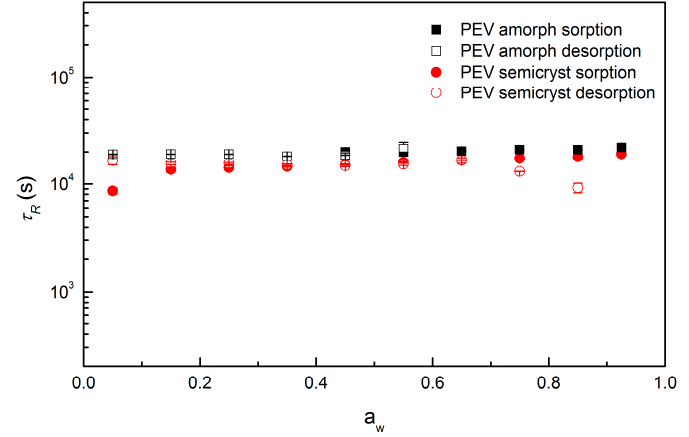
Figure 10. Plot of time of relaxation ( τ R ) from the BH model for water vapor at 20 °C in amorphous and semicrystalline PEV for sorption and desorption (two replicates for each point).